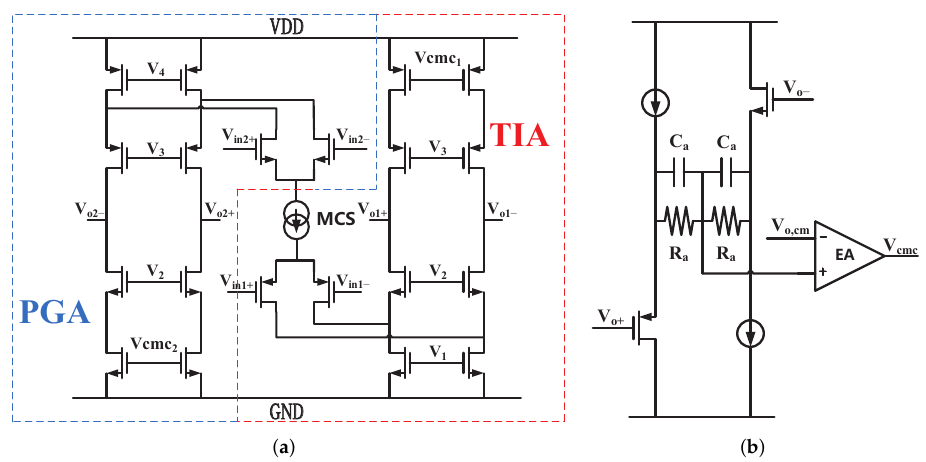
Figure 7. ( a ) Circuit implementation of current-reuse folded-cascode OTA employing a MCS and ( b ) common mode feedback